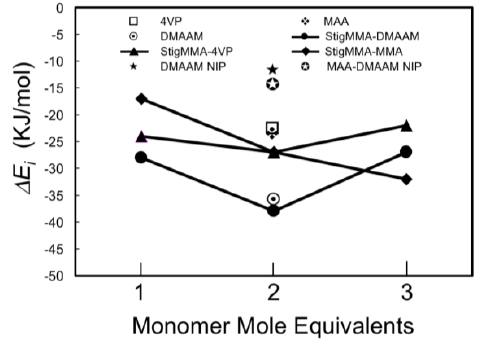
Figure 1. Modelling titration simulations for stigmasterol against three commercially available functional monomers, namely 4-vinylpyridine (4VP), methacrylic acid (MAA), and N , N (cid:48) -dimethylacrylamide ( N , N (cid:48) -DMAAM), with the change in interaction energy ( ∆ E i ) calculated for stigmasterol within the pre-polymerisation complex leading to a covalently produced cavity based on the deployment of 1, 2, or 3 free functional monomer mole equivalents. Also shown is the corresponding simulated energy ( ∆ E i ) for the non-imprinted polymer (NIP) with 2 monomer mole equivalents of